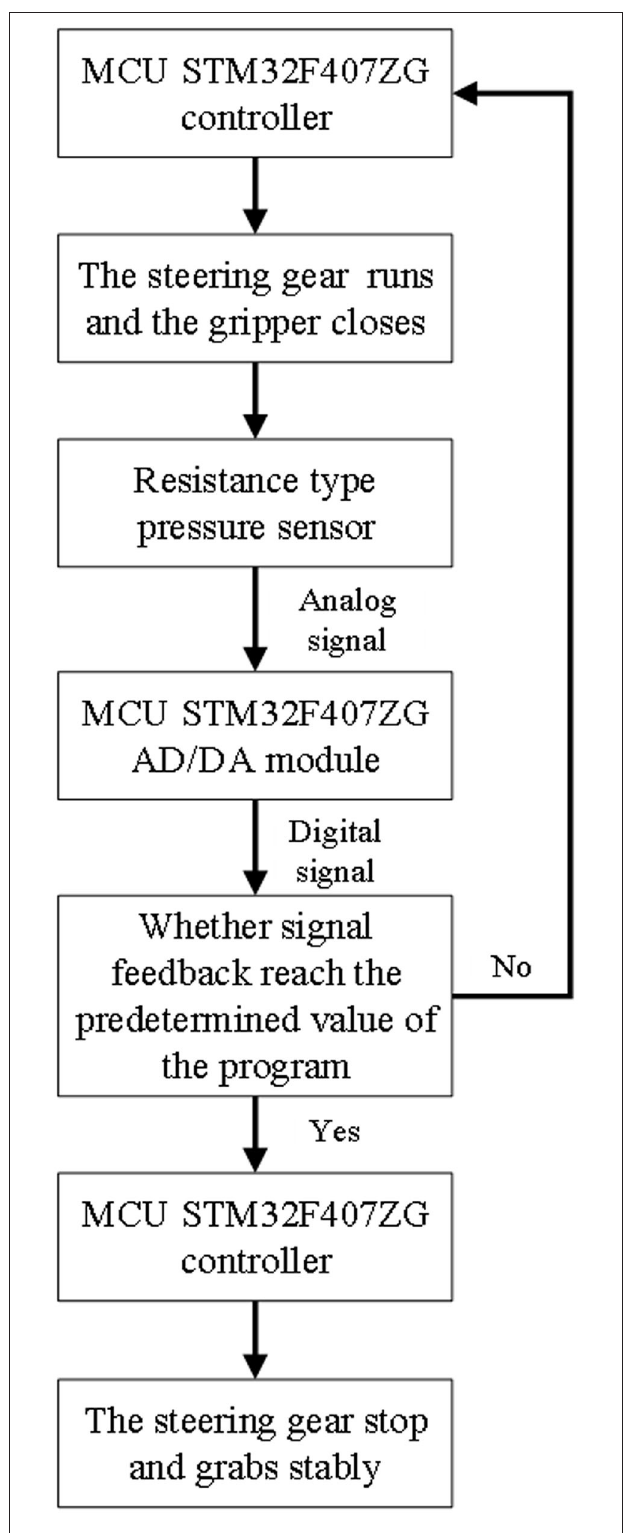
FIGURE 6 | Schematic diagram of the control